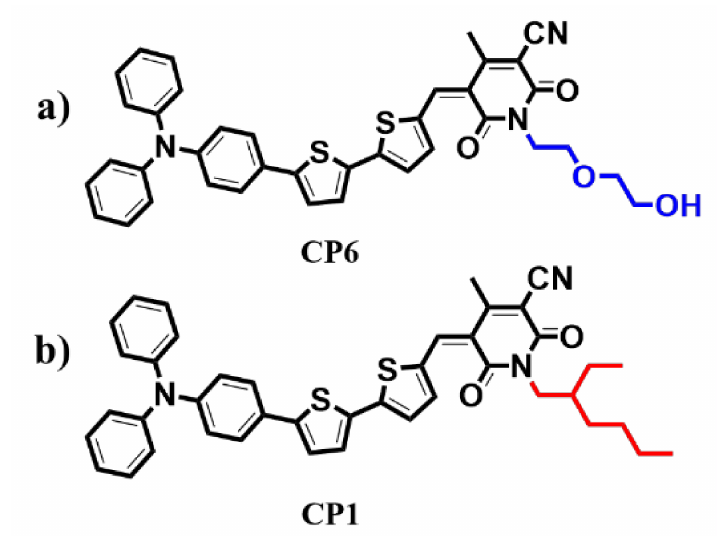
Figure 1. Chemical structures of ( a ) CP6 and ( b ) CP1